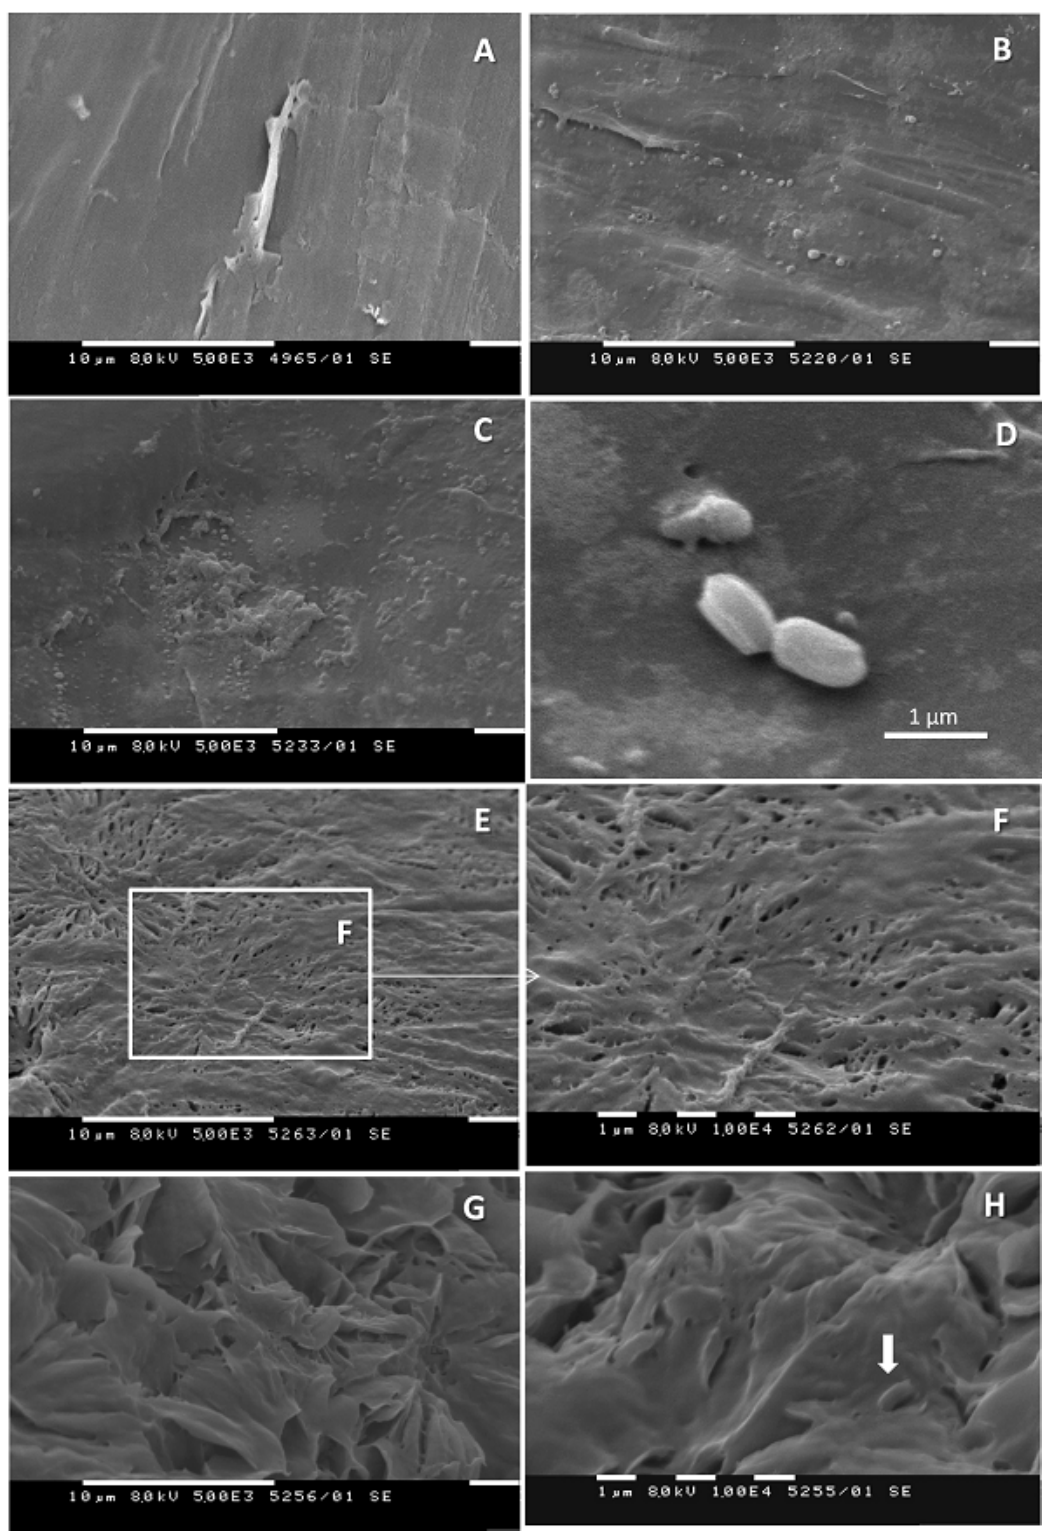
Figure 5. Changes of the surface of PCL pearls cultivated in the presence of Brevibacillus thermoruber strain 7. ( A ), control. ( B – D ), cultivation in the presence of the strain for 72 h. Deformations of the PCL surface comprise bubble-like elevations ( B , C ), single adherent bacteria are occasionally observed ( D ). ( E – H ), cultivation in the presence of the strain 7 for 3 weeks. The PCL surface is characterized by shallower ( E , F ) or deeper ( G , H ) infolds, with low incidence of attached bacteria ( H ,